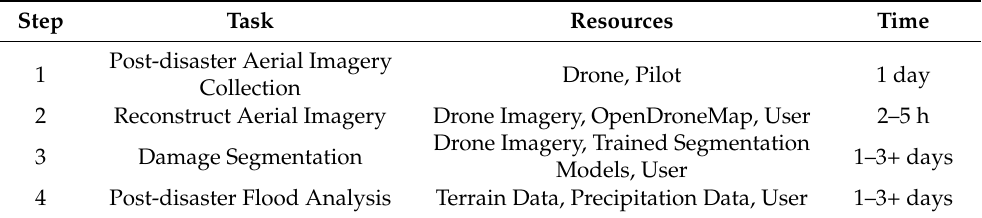
Table 1. General workflow for our flood response and recovery